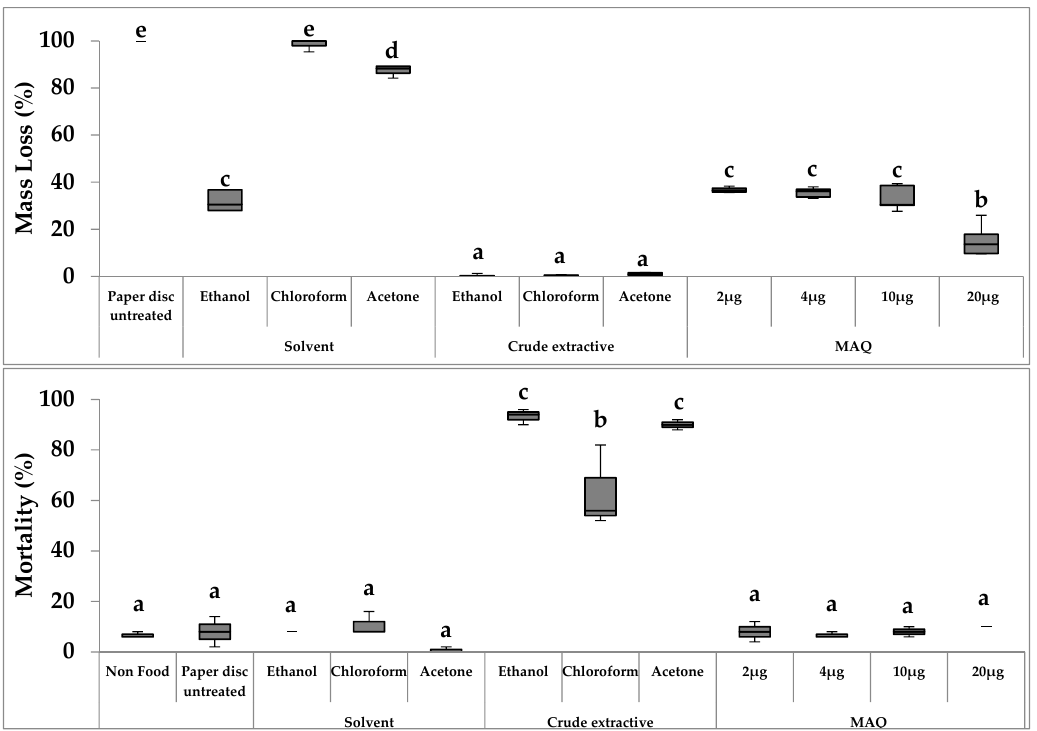
Figure 3. Box plot of mass loss and mortality of R. speratus in no-choice feeding tests using filter paper discs treated with T. grandis crude extractives and MAQ. Notes: Treatments with the same letters in the same graphic are not statistically different at p < 0.05, as determined by Duncan’s test; Dosages of the extractives and MAQ are indicated in Table 1.